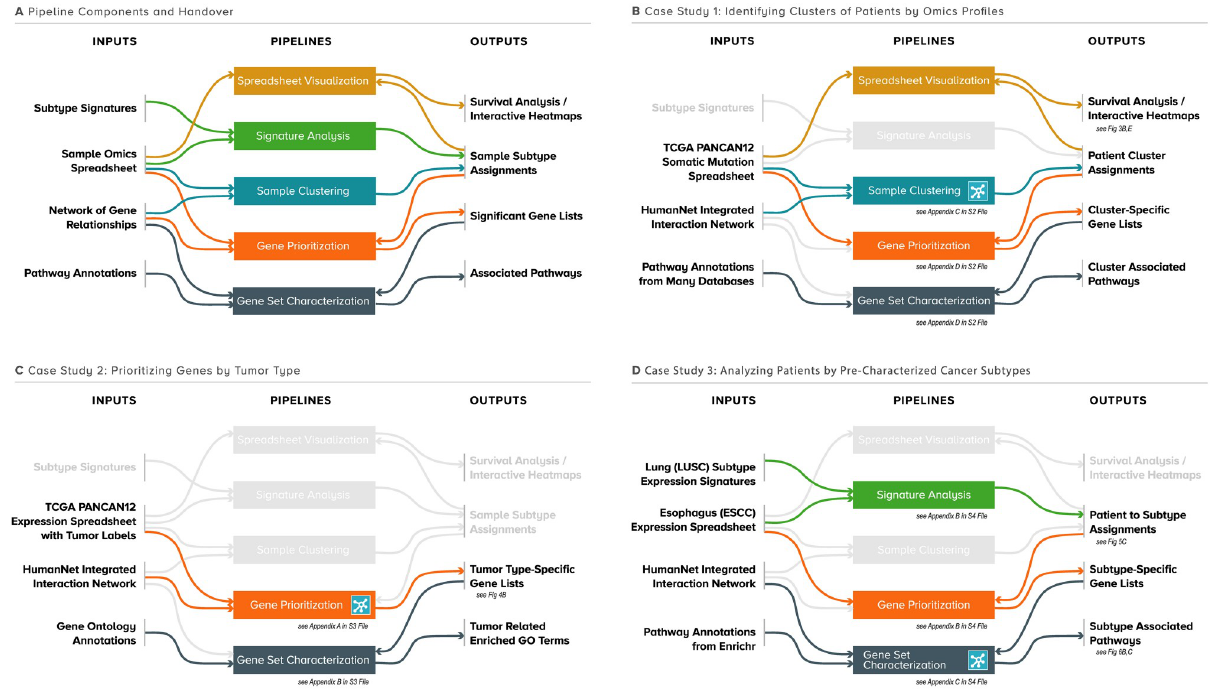
Fig 2. Case studies demonstrating knowledge-guided analysis. (A) Each of the KnowEnG analysis pipelines is shown as a box with corresponding colored arrows connecting to their general inputs and outputs. Because the outputs of a pipeline are often valid inputs for another pipeline, a convenient “handover” mechanism in the KnowEnG web portal enables chaining together multiple pipelines, facilitating deeper and multifaceted analysis of the user’s data. (B) The analysis workflow for Case Study 1 with unused pipelines shaded gray. Simple descriptions of the case study–specific inputs and outputs are provided, along with notes on where to find the detailed methods or figures of the results. The pipeline step of the workflow that incorporates knowledge-guided analysis is indicated with the blue network icon. (C) Analysis workflow for Case Study 2. (D) Analysis workflow for Case Study 3. ESCC, esophageal squamous cell carcinoma; GO, Gene Ontology; KnowEnG, Knowledge Engine for Genomics; LUSC, lung squamous cell carcinoma; TCGA, the Cancer Genome Atlas.